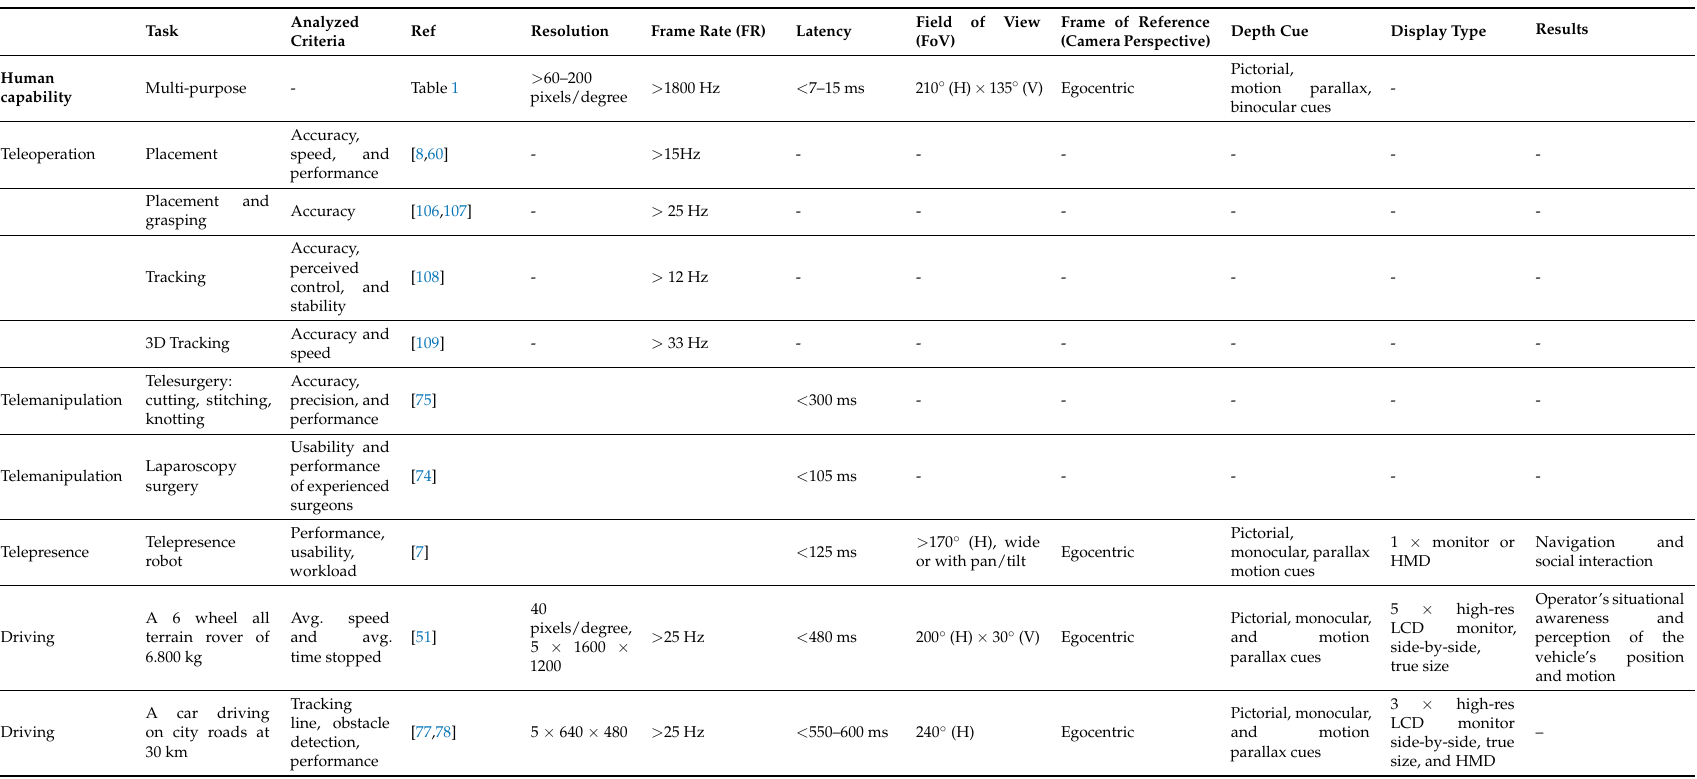
Table A1. Human capabilities vs. human capabilities through mediated